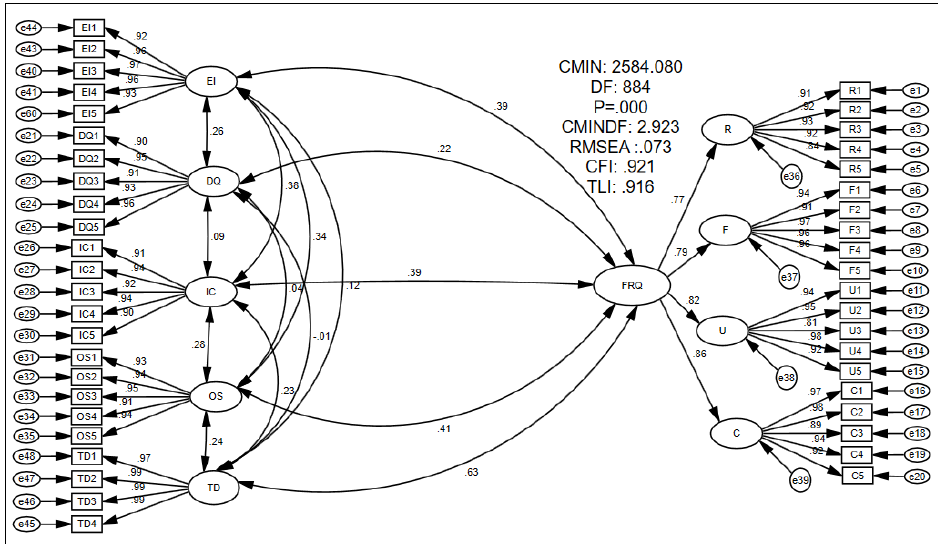
Figure 3. Assessment of measurement model.